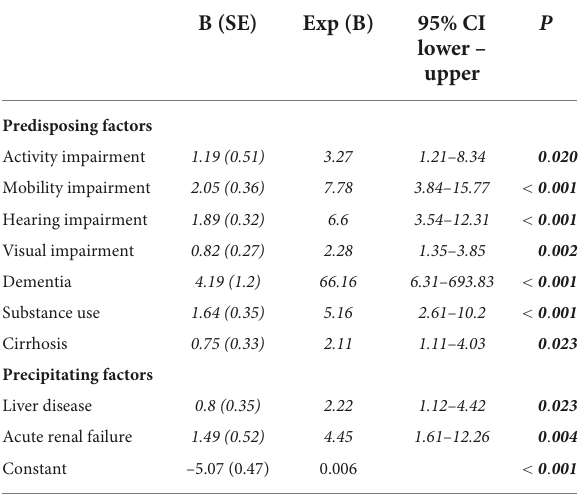
Thepopulationwasdichotomizedintodeliriousandnon-delirious.Oddsratios(OR) > 1 indicate a strong association with the patient group (when compared with the variable reference level) whereas ORs < 1 represent no association with the patient group (when compared with the variable reference level). Cox–Snell and Nagelkerke r2 = 0.413 and r2 = 0.613. Displayed are estimated coefficients (B, SE), 95% confidence intervals, and P -values. Bold values indicated significant results. SE, standard error; CI, confidence interval. B: estimated coefficient, Exp (B): exponential value of B corresponds to odds ratio,P: P